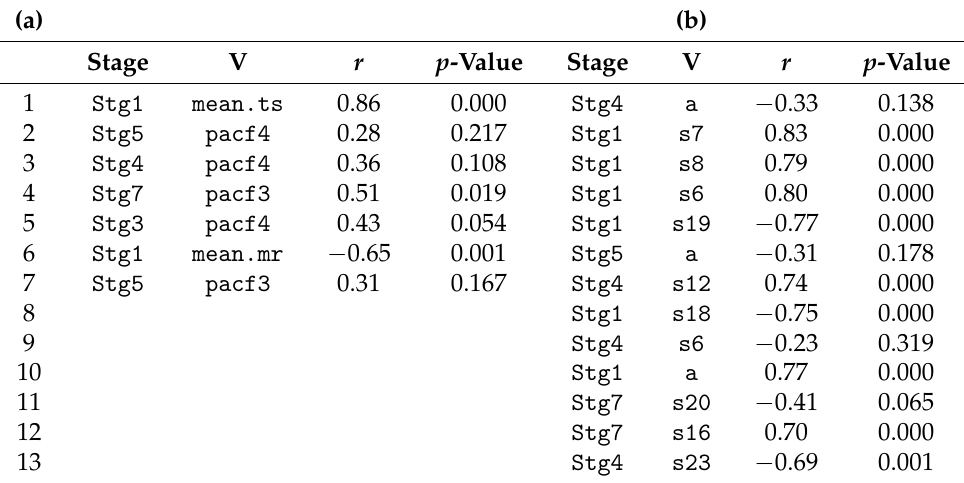
Table 2. Results from sPLS: variables selected (V), ordered from top to bottom according to VIP j . The monthly stage is indicated as Stg1 (August) to Stg7 (February). Correlation coefficients ( r ) of each selected variable vs. sensor height, and the corresponding p -values of the correlation test. Results are presented in accordance with the variables used in sPLS: ( a ) Method 1 and ( b ) Method